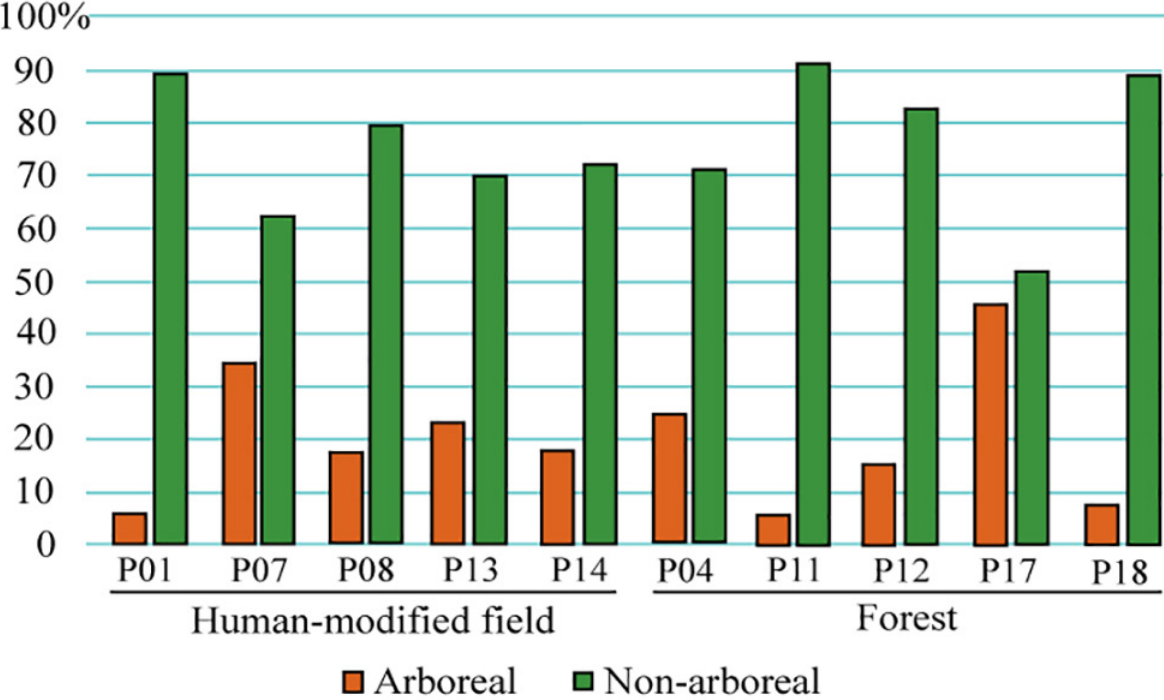
Figure 6. Percentage of arboreal and non-arboreal pollen grains for each point